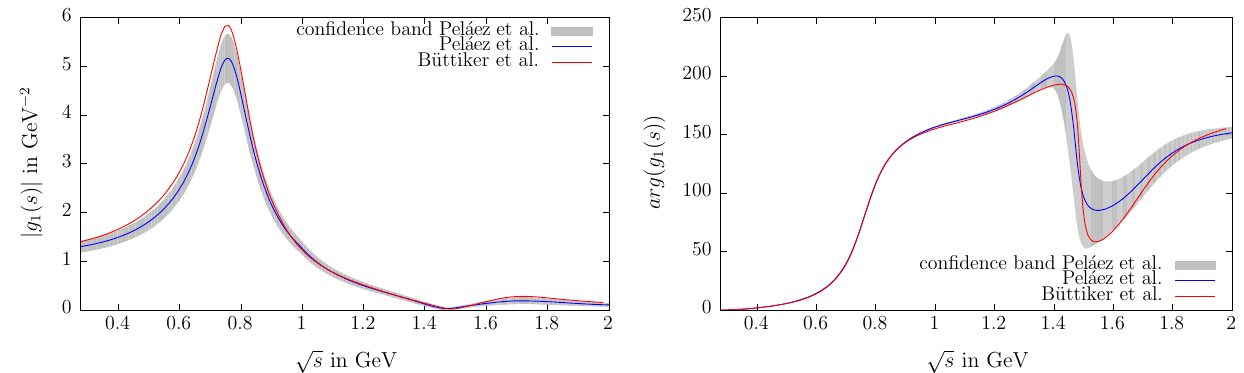
( s ) with the parameterization from Ref. [81] including the confidence band in blue. As a comparison, the Fig. 2 The ππ → K ¯ K partial wave g 1 1 parameterization from Ref. [48] is shown in red